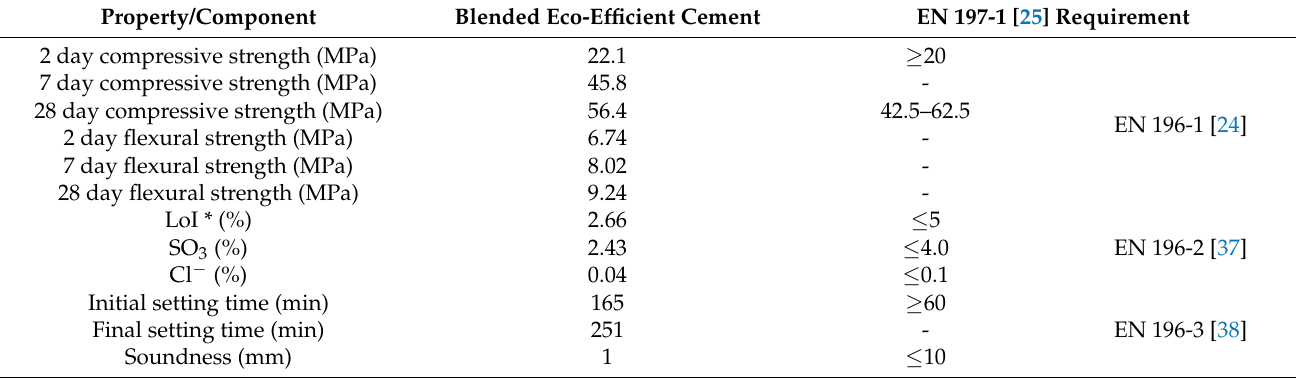
Table 7. Mechanical, chemical and physical characterisation of eco-efficient